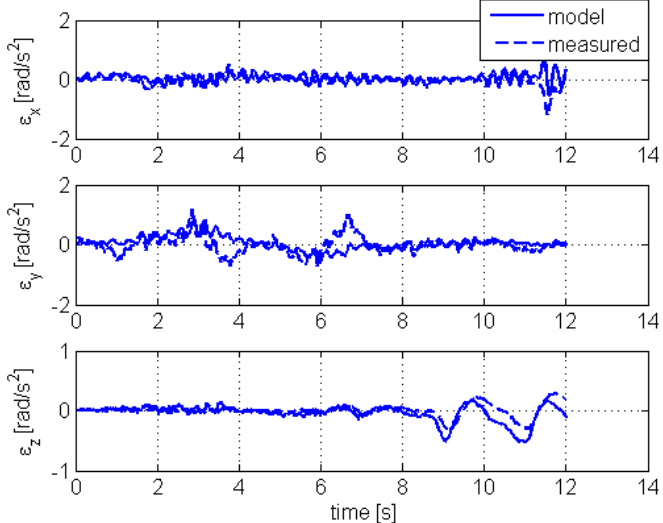
Figure 11. Results of experiment no. 3: angular accelerations in x , y , z ∈ EF coordinates for Falcon V5 real UAV (measured) and its